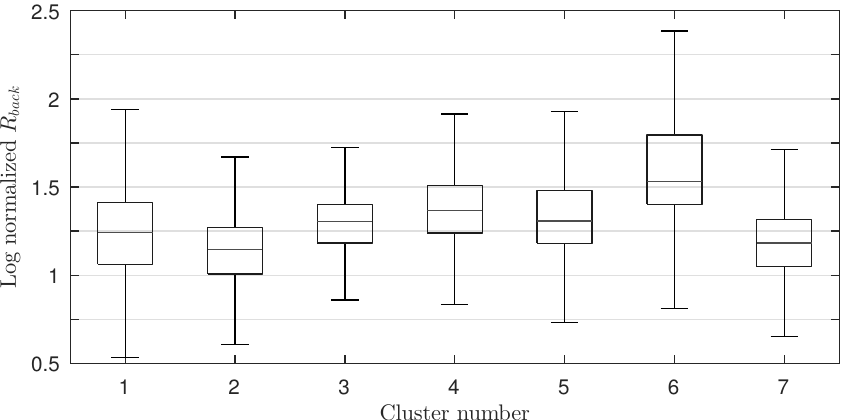
Figure 8. Boxplot representation of the distribution of the R seven